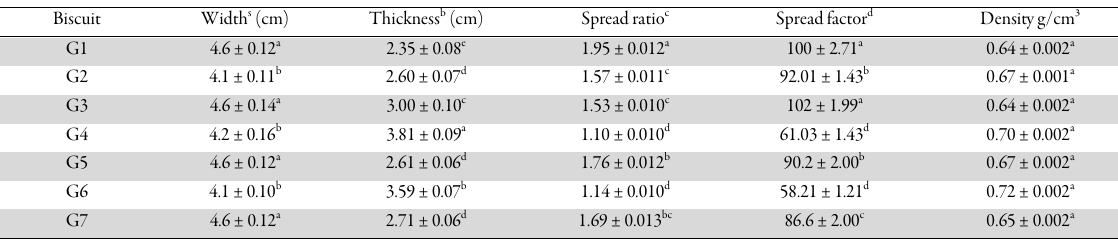
Table 6. Physical properties of colored wheat flour biscuits made using the natural color and synthetic color (mg /100g dry weight) Biscuit